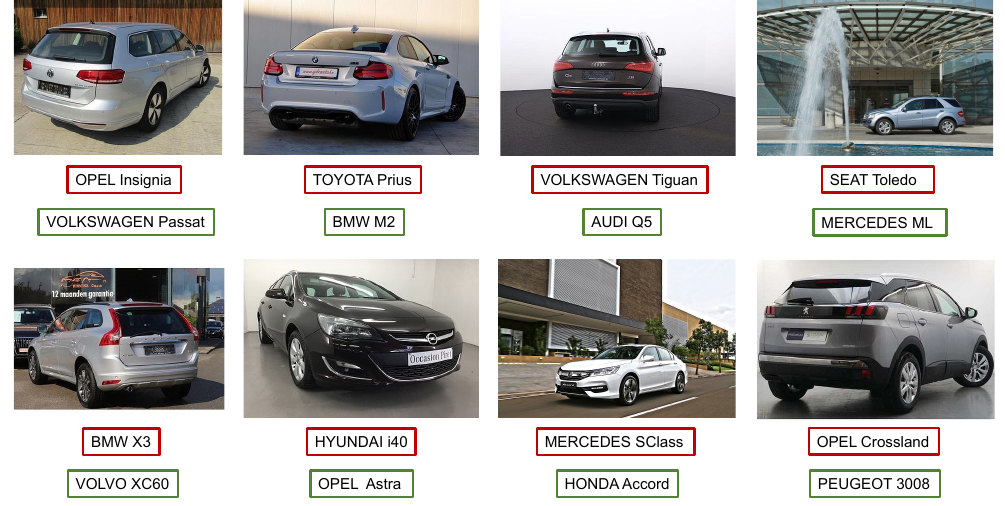
Figure 11. Visualization of the vehicle model classification confusion of 1B (red bounding boxes) and the corrected predictions of the corresponding 2B–2S (green bounding